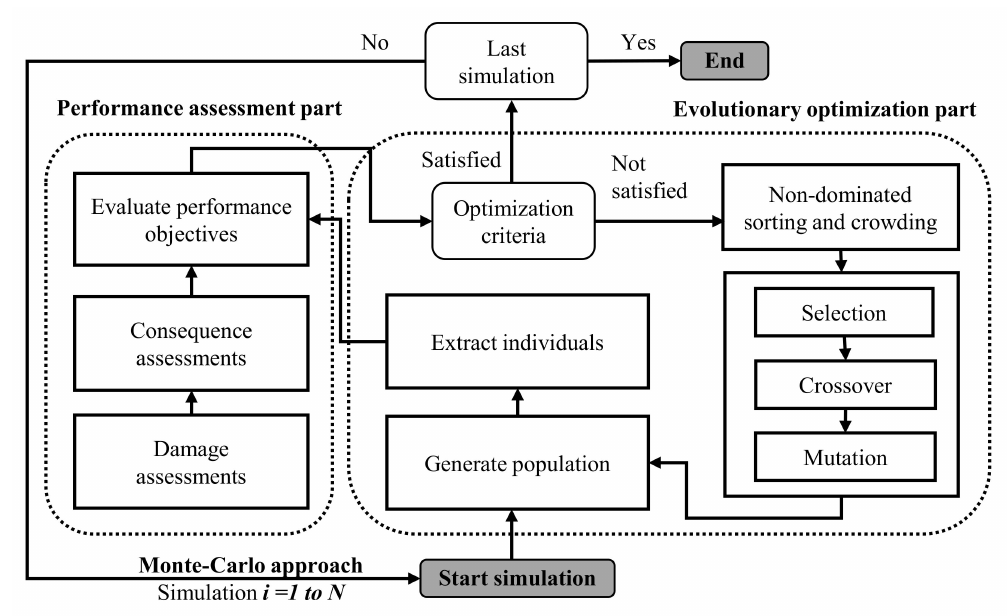
Figure 1. Bi-objective retrofit optimization framework for community building portfolio considering uncertainties.